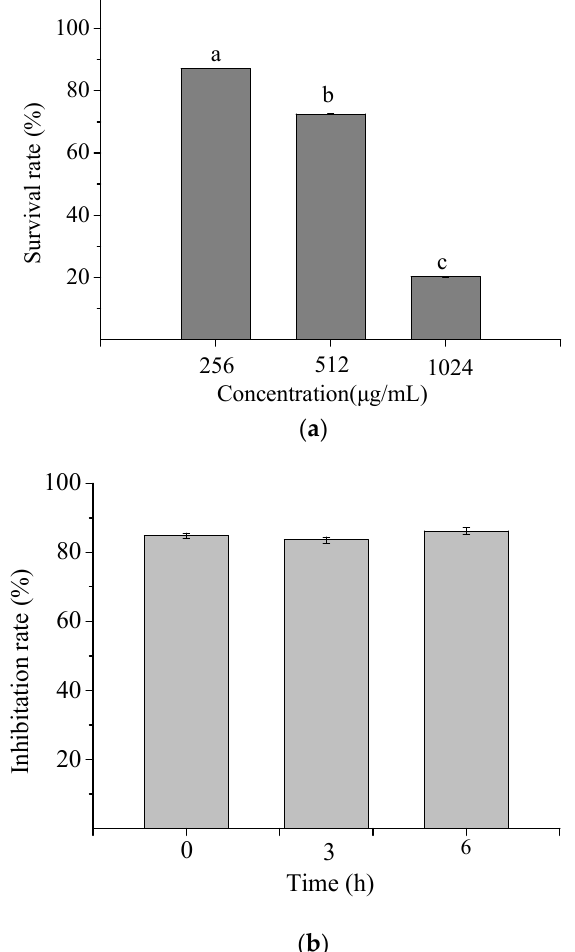
Figure 2. Cytotoxicity ( a ) and serum stability ( b ) of NP-6. The values represent the means ± SD ( n = 3). Bars with different letters are significantly different ( p < 0.05).